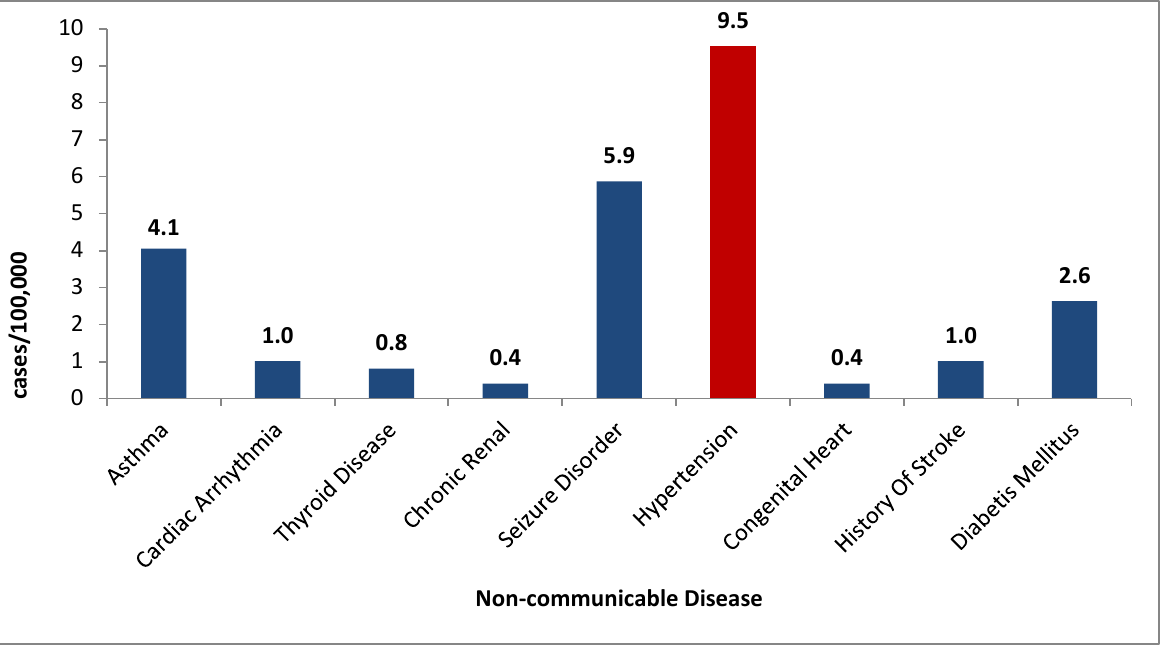
Figure 13: Non-communicable diseases as reported by Congolese refugees during overseas medical examinations at panel physician sites, 2008 – 2012